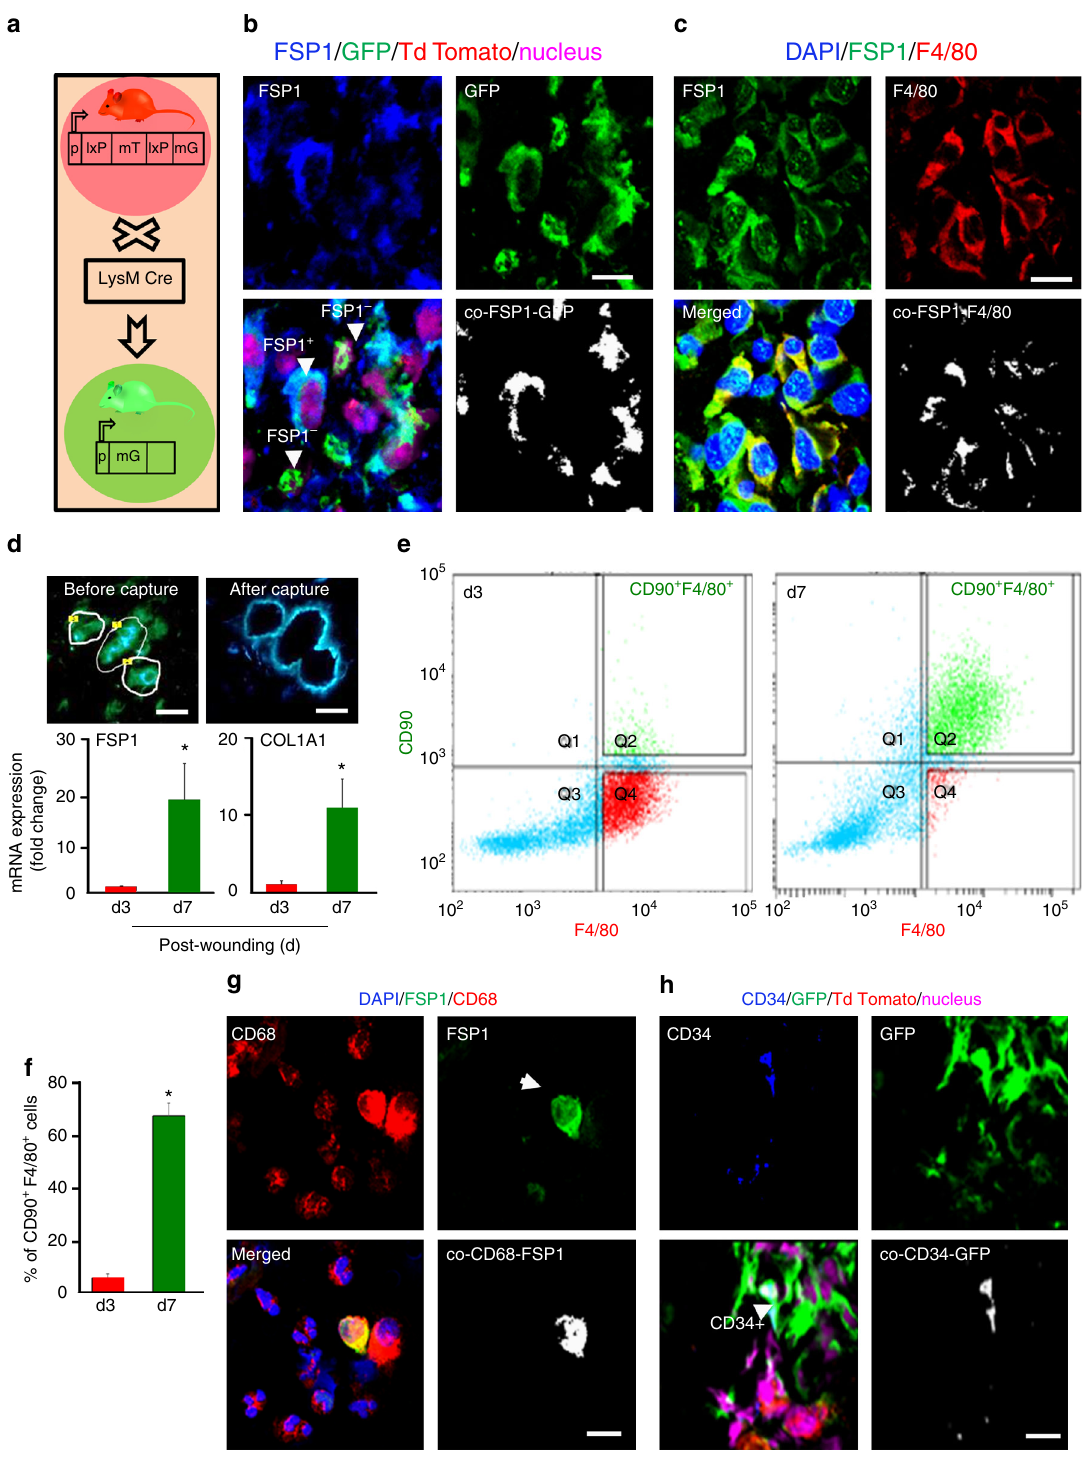
Fig. 1 Majority of FSP1 + fi broblast-like cells in wound granulation tissue are of myeloid origin. a LysM Cre Rosa mT/mG mice express cell membrane-localized td Tomato (red) fl uorescence while cells of myeloid origin express GFP (green) fl uorescence. b FSP1 (blue) immunostaining of LysM Cre Rosa mT/mG mice d5 wound. Colocalization was performed using Olympus Fluoview ® software. Estimated (65 ± 5%) FSP1 + cells (blue) were GFP + demonstrating their myeloid origin, n = 5, scale bar = 10 µ m. c Macrophage (F4/80, red) and fi broblast (FSP1, green) immunostaining at wound-edge tissue (d5) from C57BL/6 mice, n = 5, scale bar = 10 µ m. d Laser capture micro-dissected (LCM) GFP + cells from full thickness excisional wounds on d3 (early in fl ammation phase) or d7 (in fl ammation resolution phase) post-wounding (PW), scale bar = 10 µ m. qRT-PCR of LCM-captured GFP + cells showed increased expression of FSP1 and Col1A1 at d7, n = 5, Student ’ s t test p < 0.05. e , f Multicolor fl ow cytometry of CD11b + of wound macrophages on d3 and d7 PW with the